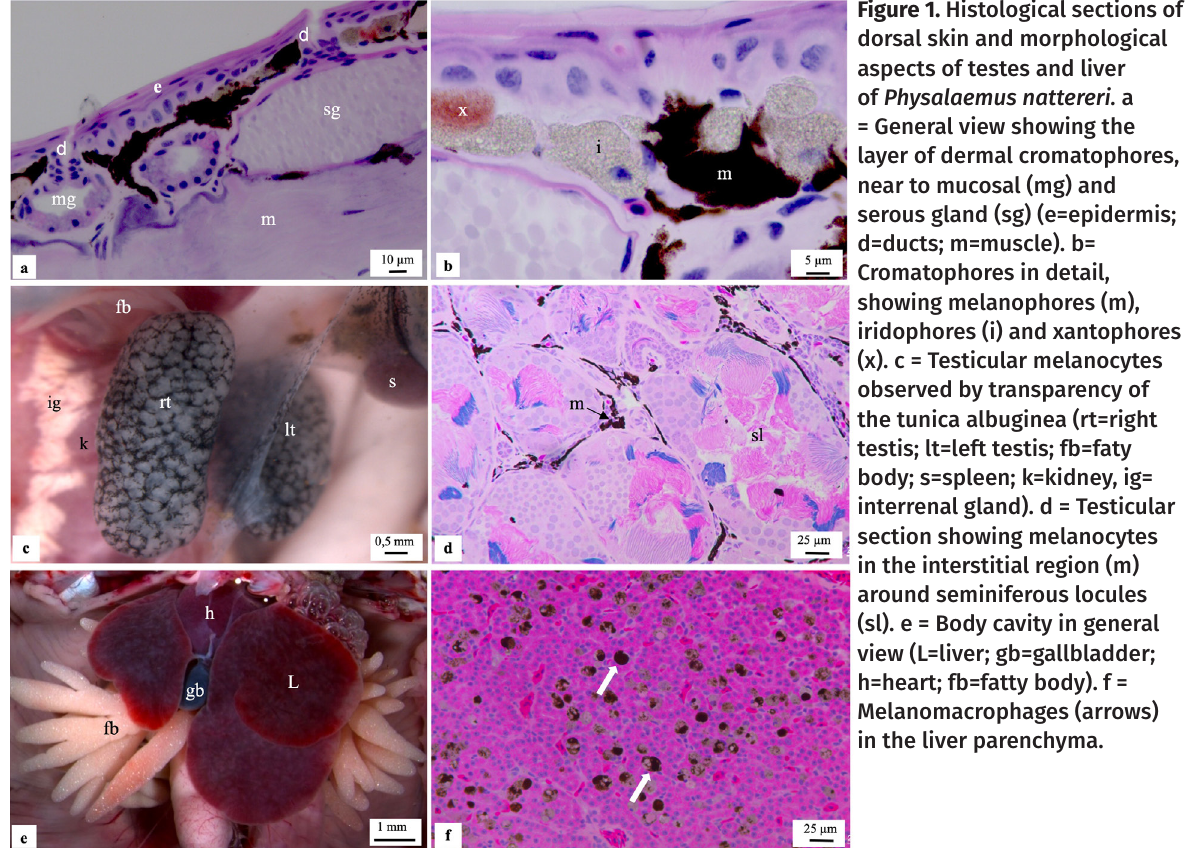
Figure 1. Histological sections of dorsal skin and morphological aspects of testes and liver of Physalaemus nattereri. a = General view showing the layer of dermal cromatophores, near to mucosal (mg) and serous gland (sg) (e=epidermis; d=ducts; m=muscle). b= Cromatophores in detail, showing melanophores (m), iridophores (i) and xantophores (x). c = Testicular melanocytes observed by transparency of the tunica albuginea (rt=right testis; lt=left testis; fb=faty body; s=spleen; k=kidney, ig= interrenal gland). d = Testicular section showing melanocytes in the interstitial region (m) around seminiferous locules (sl). e = Body cavity in general view (L=liver; gb=gallbladder; h=heart; fb=fatty body). f = Melanomacrophages (arrows) in the liver